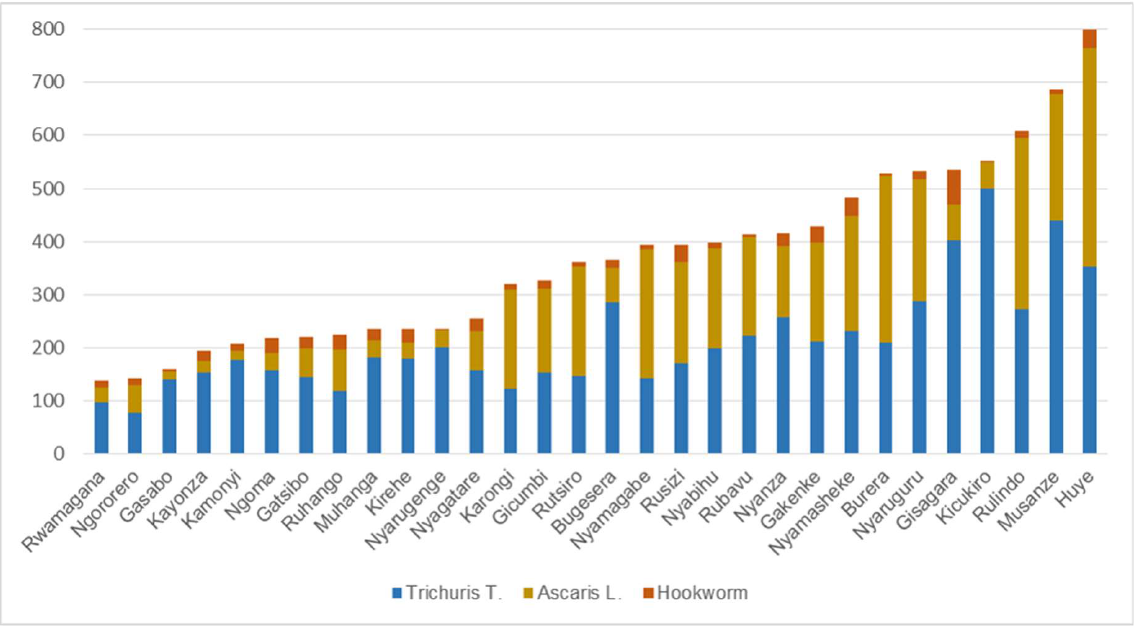
Figure 2. STH incidence rates (per 10,000 persons) per district in Rwanda for 2008, as reported in